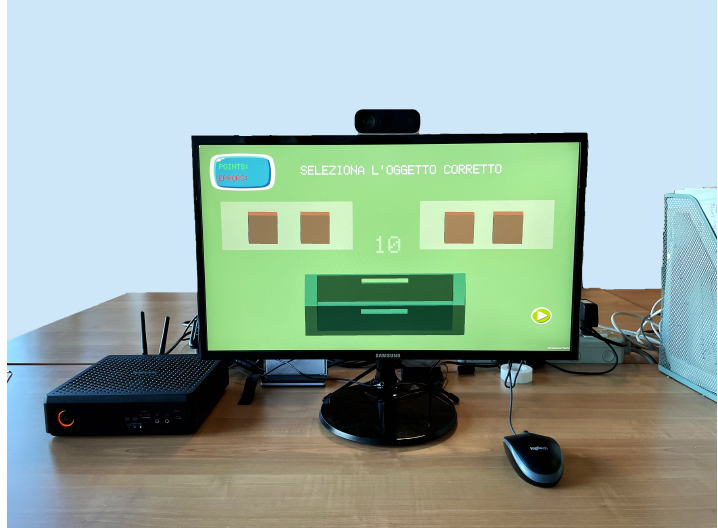
Figure 4. Acquisition system setup for the experimental sessions.